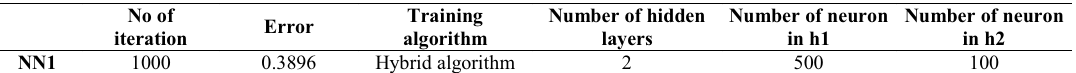
Table 4. Neural network parameters